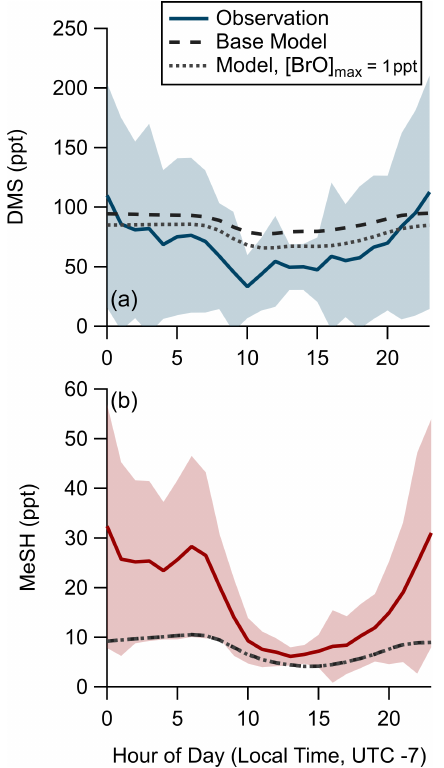
Figure 7. Observed and modeled diel profiles of (a) DMS and (b) MeSH mixing ratios.